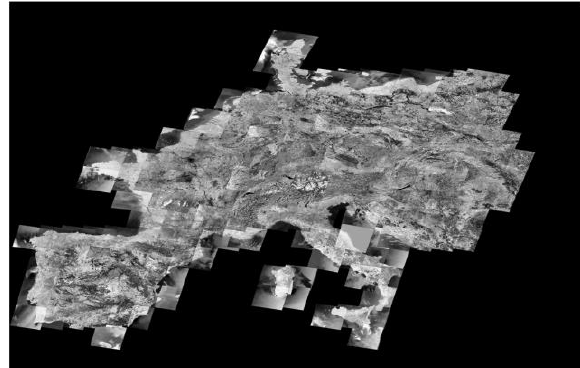
Figure 4. Histogram equalized Landsat visible image mosaic.